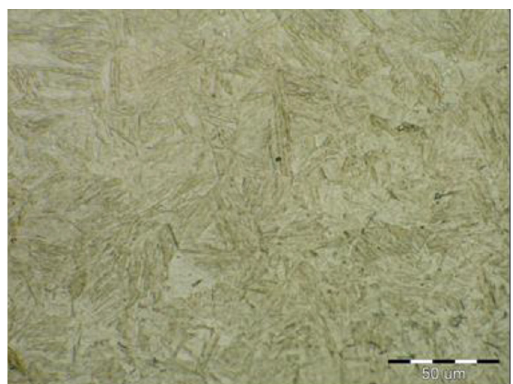
Figure 20. Microstructure in the middle of weld metal area formed by martensite and bainite (TRIP).